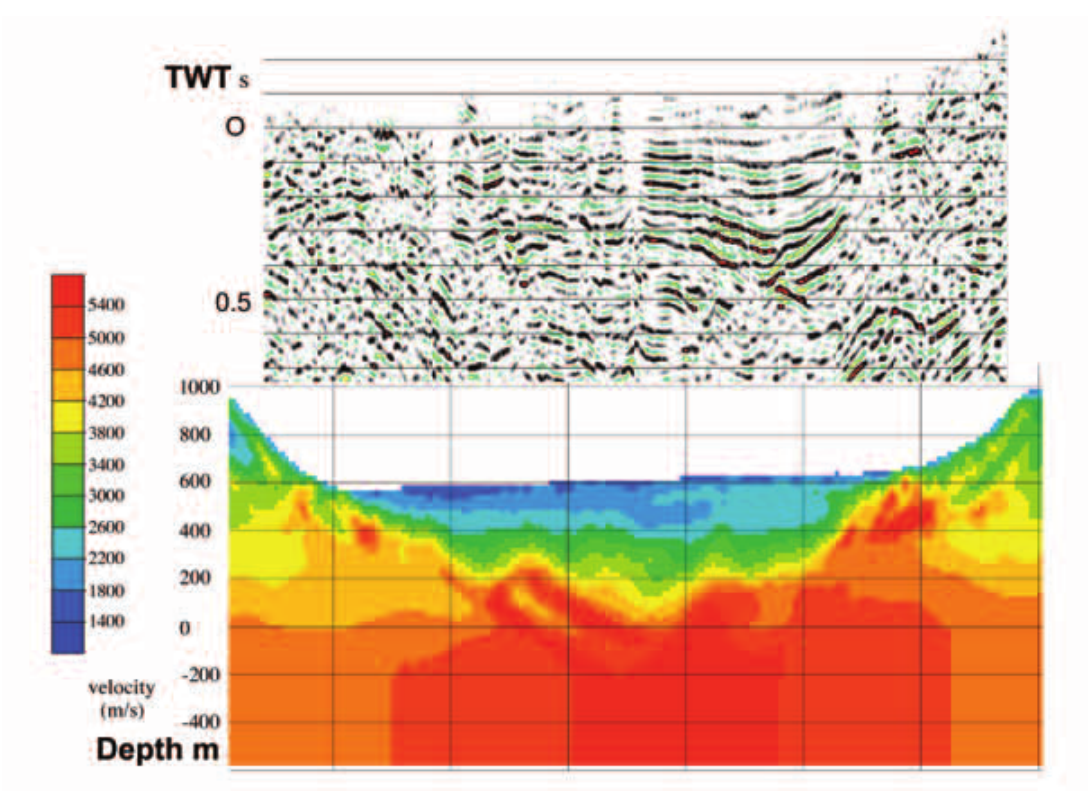
Fig. 10. Conventional time seismic versus tomography velocity/depth